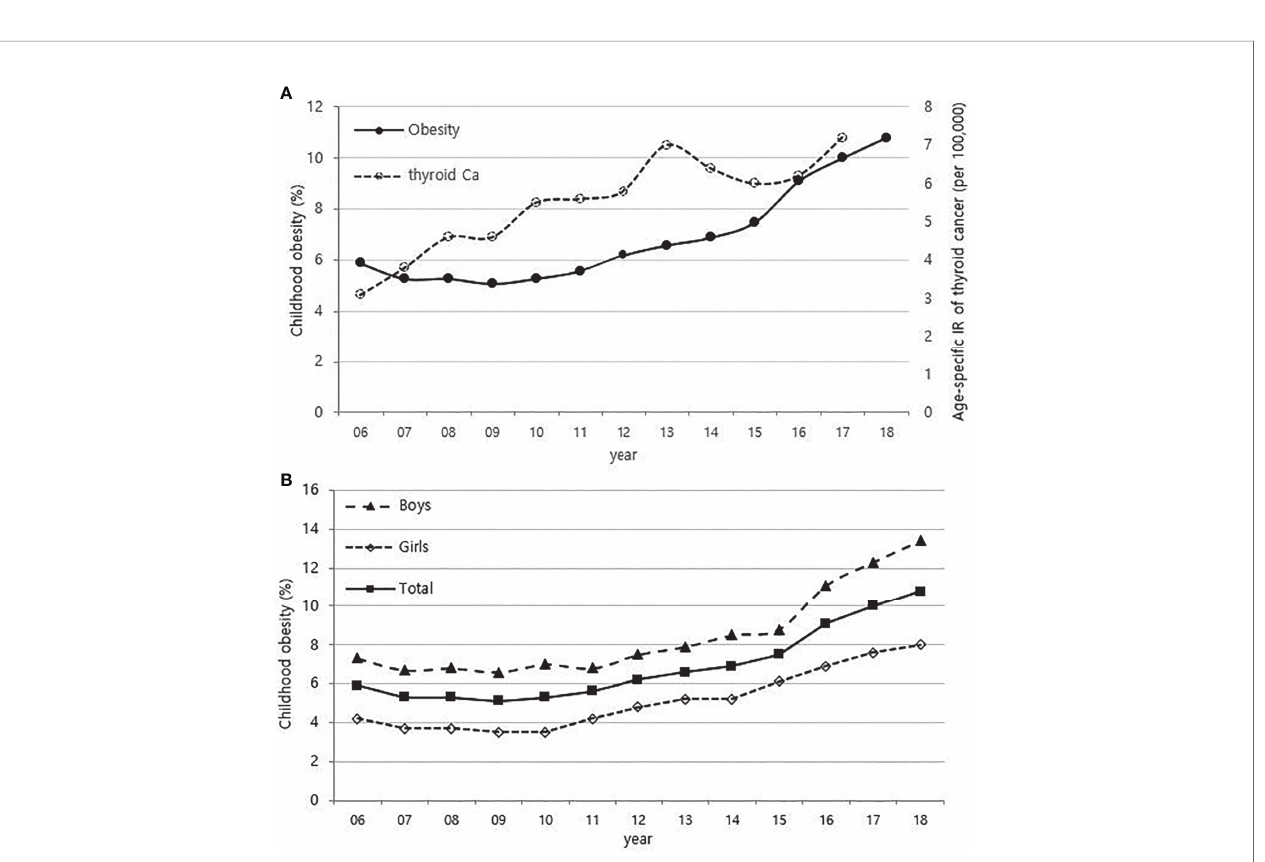
FIGURE 5 | Correlation between childhood obesity prevalence (13-18 years) (2006-2018) and age-speci fi c incidence rate of childhood thyroid cancer (0-18 years) by year in Korea (2006-2017, per population of 100,000) (A) . Childhood obesity prevalence according to sex (B) . Ca, cancer; IR, incidence